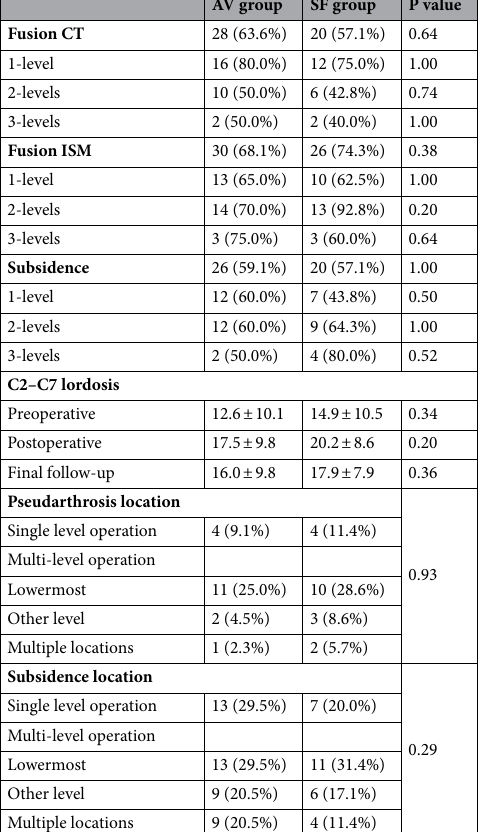
AV group SF group P